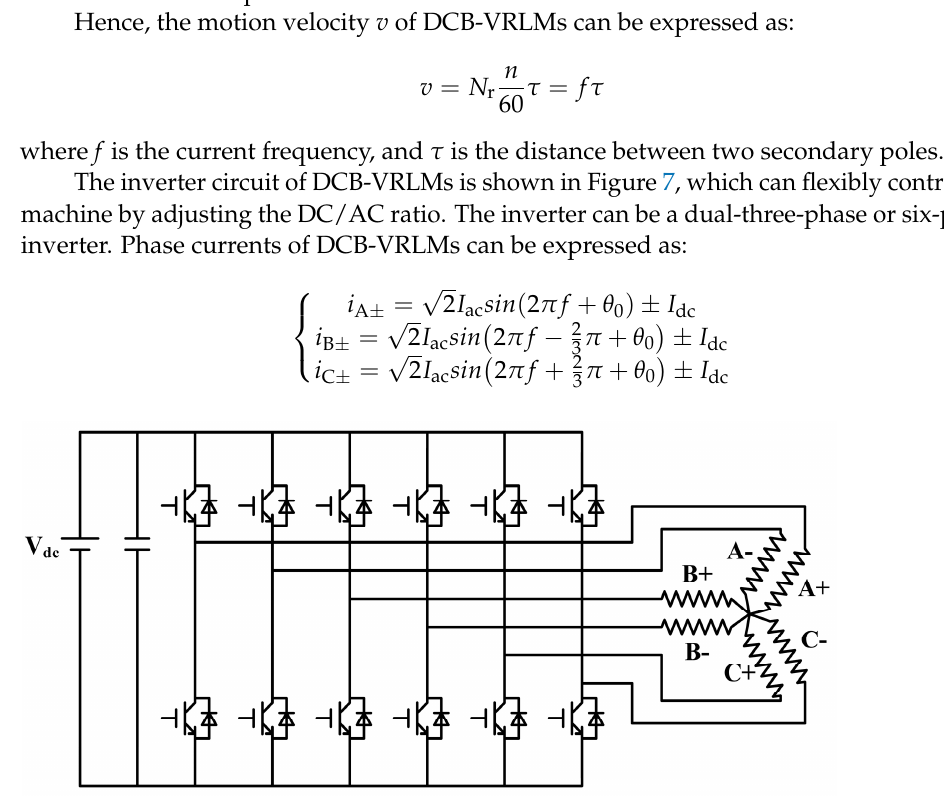
Figure 7. The inverter circuit of DCB ‐ VRLMs.